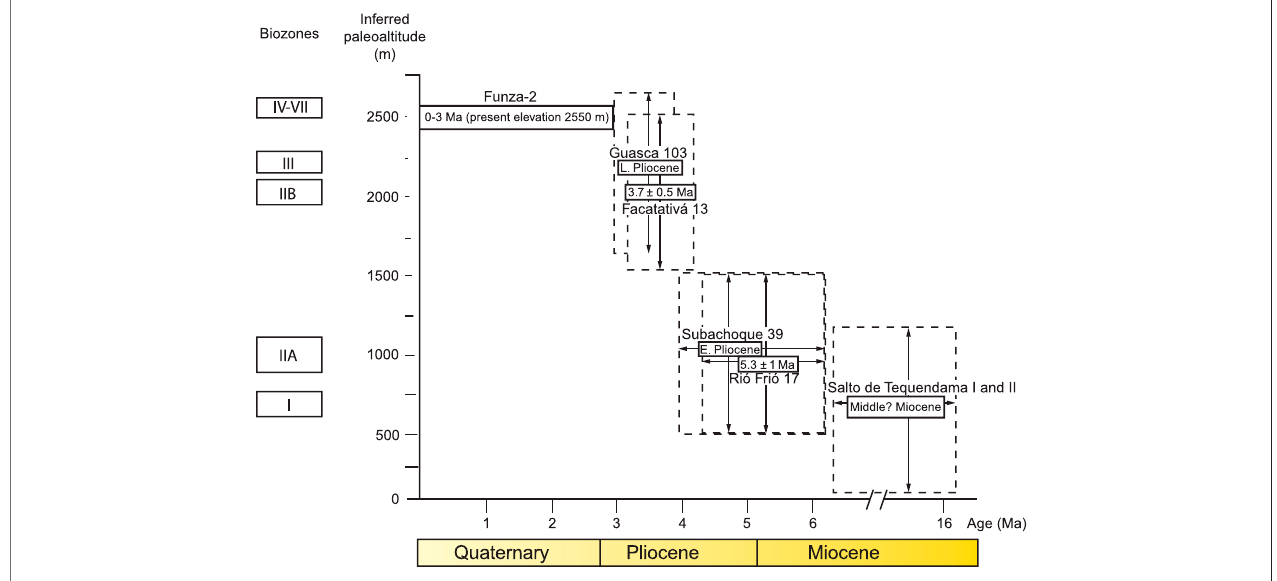
FIGURE 6 | Paleoaltimetry estimations based on fossil pollen spectra analysis for the Bogota Savanna and surrounding areas (modi fi ed from Hooghiemstra et al., 2006; Wijninga, 1996).